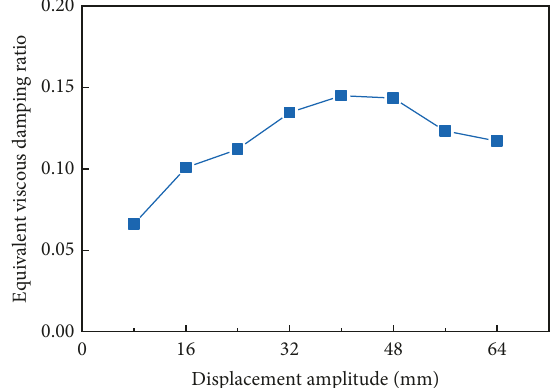
Figure 16: Equivalent viscous damping ratio vs. displacement amplitude